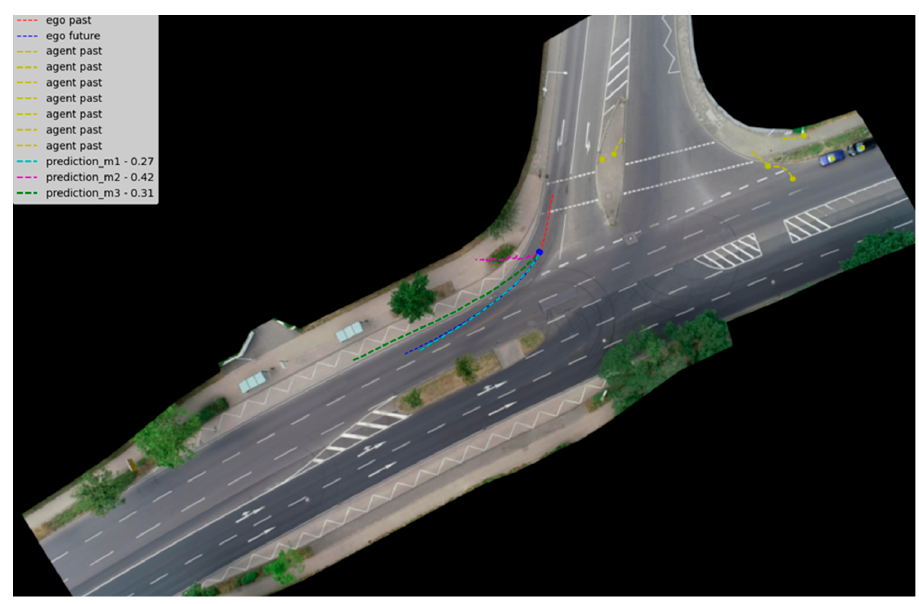
Figure 17. Traffic scene prediction with the multimodal approach. In this scenario, the bicyclist has the most probable maneuver drawn with magenta (going to the sidewalk), the second one drawn with green (going to the bus station), and the third one drawn with blue (following the lane).